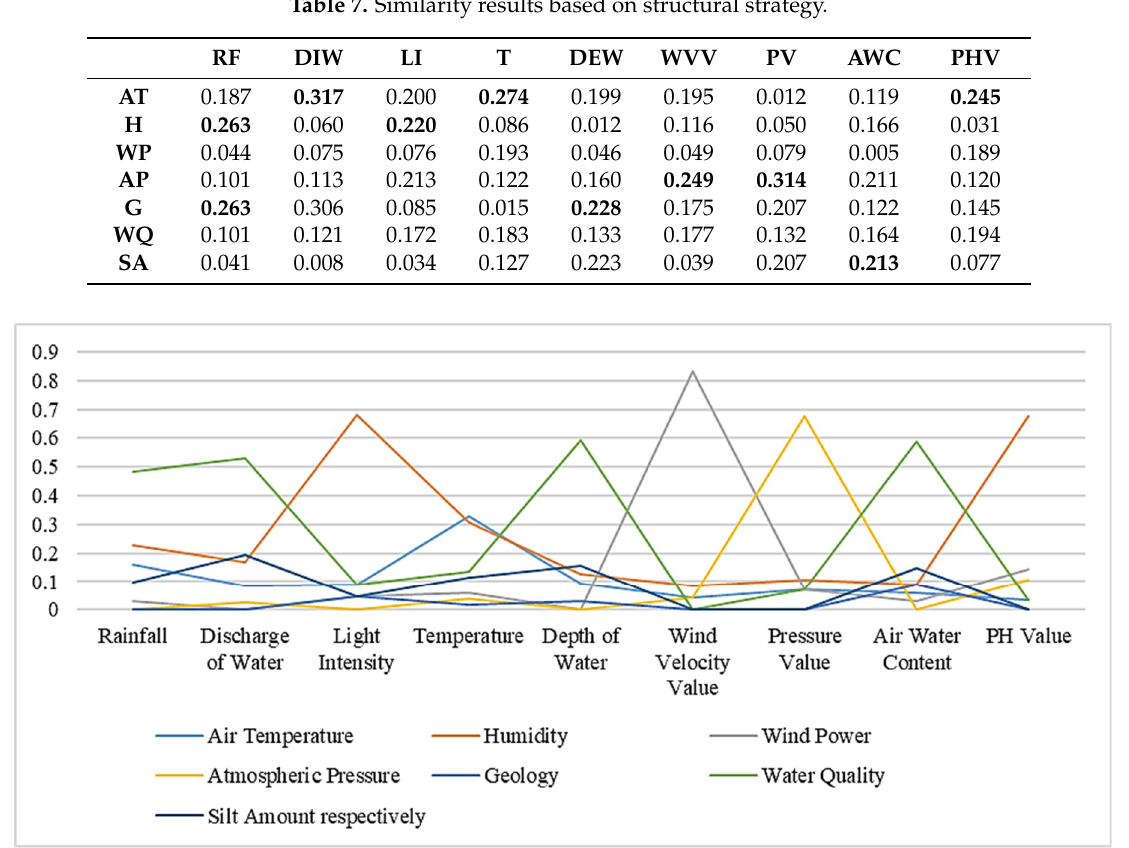
Figure 3. Similarity results based on semantic strategy.